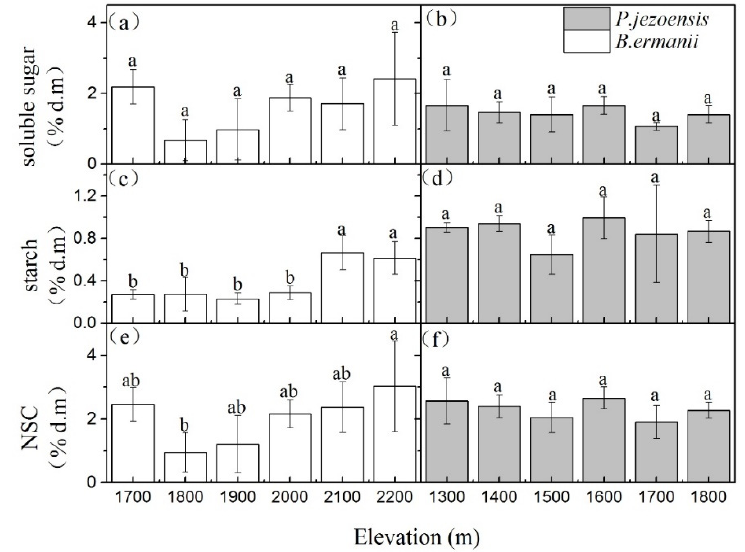
Figure 4. Variation in the concentrations of B. ermanii stems (a) soluble sugar, (c) starch and (e) NSC as well as P. jezoensis stems (b) soluble sugar, (d) starch and (f) NSC (mean ± SD; % of dry matter) along with elevational gradients in Changbai Mountain ( n = 5 for each elevational site). Different letters indicate significant differences ( p < 0.05) among elevations as determined by Tukey’s HSD test single-factor ANOVAs.